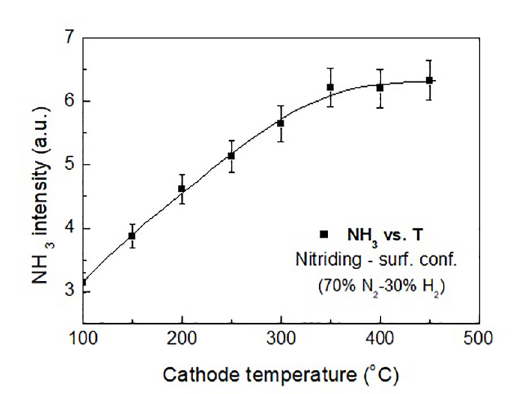
Figure 13. Evolution dependency of the ammonia ion peak (NH3 + ) with the temperature of the steel cathode, during